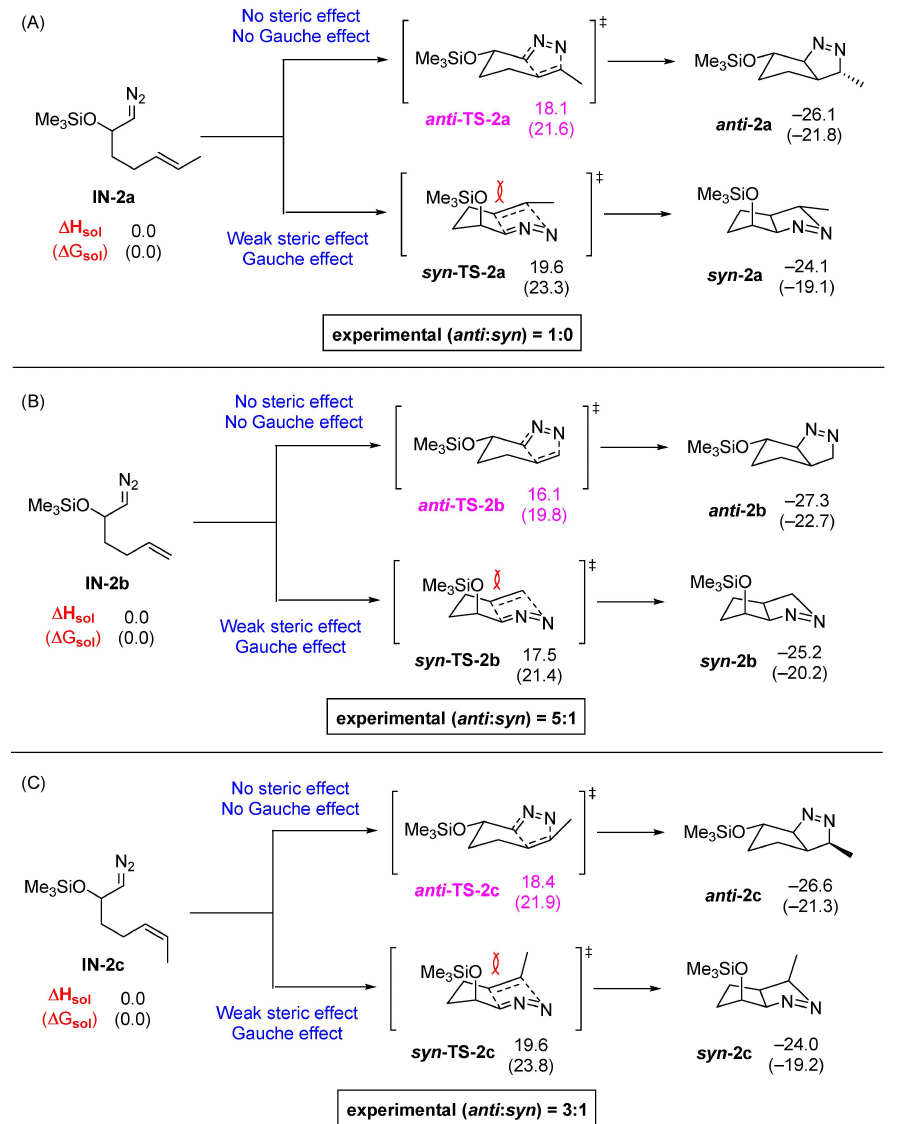
Figure 7. DFT calculations on pyrazolines formed with high anti -diastereoselectivity (in kcal/mol). ( A ) Energy profile for E -alkene; ( B ) Energy profile for terminal alkene; ( C ) Energy profile for Z -alkene.